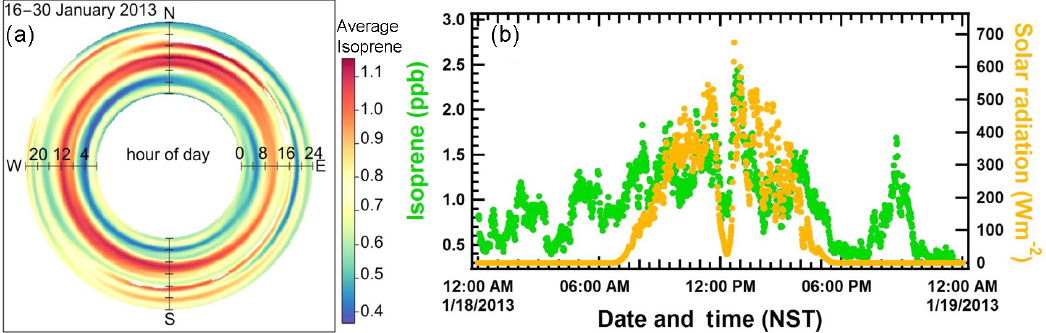
Figure 8. (a) Polar annulus plot of isoprene for the period 16–30 January 2013 highlighting the spatiotemporal variation of isoprene and its biogenic sources; (b) co-variation of daytime isoprene concentrations with solar radiation on 18 January